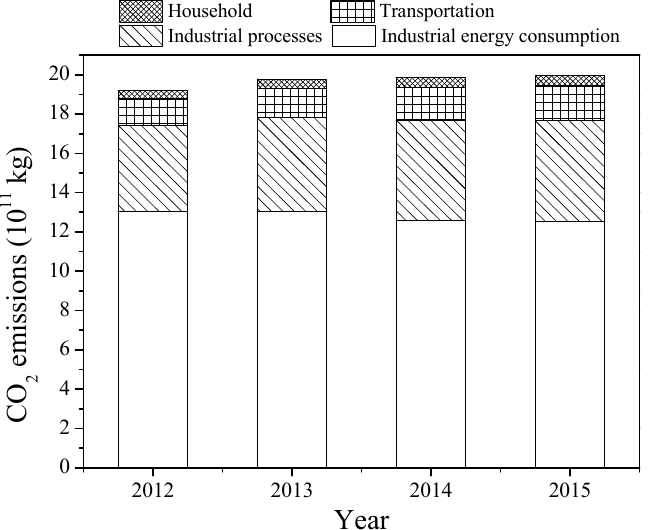
Figure 10. Annual anthropogenic CO 2 emissions from different sectors in the YRD from 2012 to 2015, based on the IPCC inventory method.